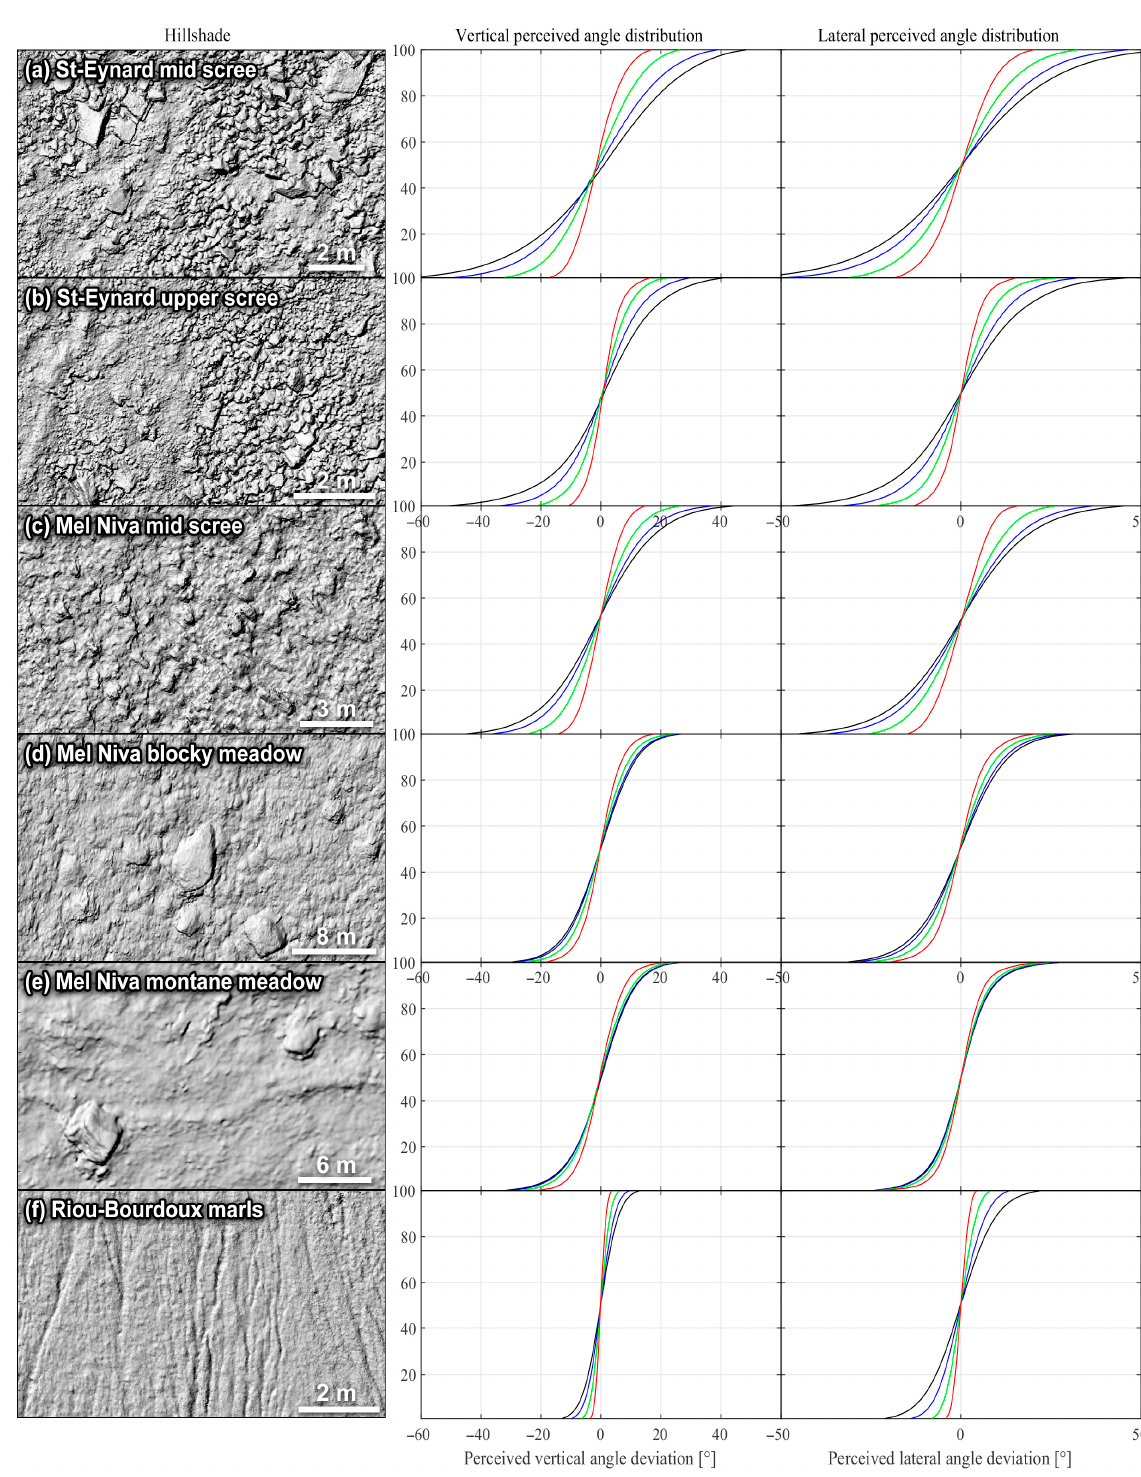
Figure 13. Vertical and lateral perceived deviation angles for the six tested sites with four different impacting rock sizes (more than 20 million detected impacts summarized here). The left column shows the surface’s shaded top views of the sites. The middle column shows the vertical perceived deviation angles. The right column shows the lateral perceived deviation angles. The vertical axis of each graph corresponds to the centiles. The results for the 0.3, 1.0, 3.0 and 10 m wide rocks are represented with black, blue, green, and red lines, respectively.